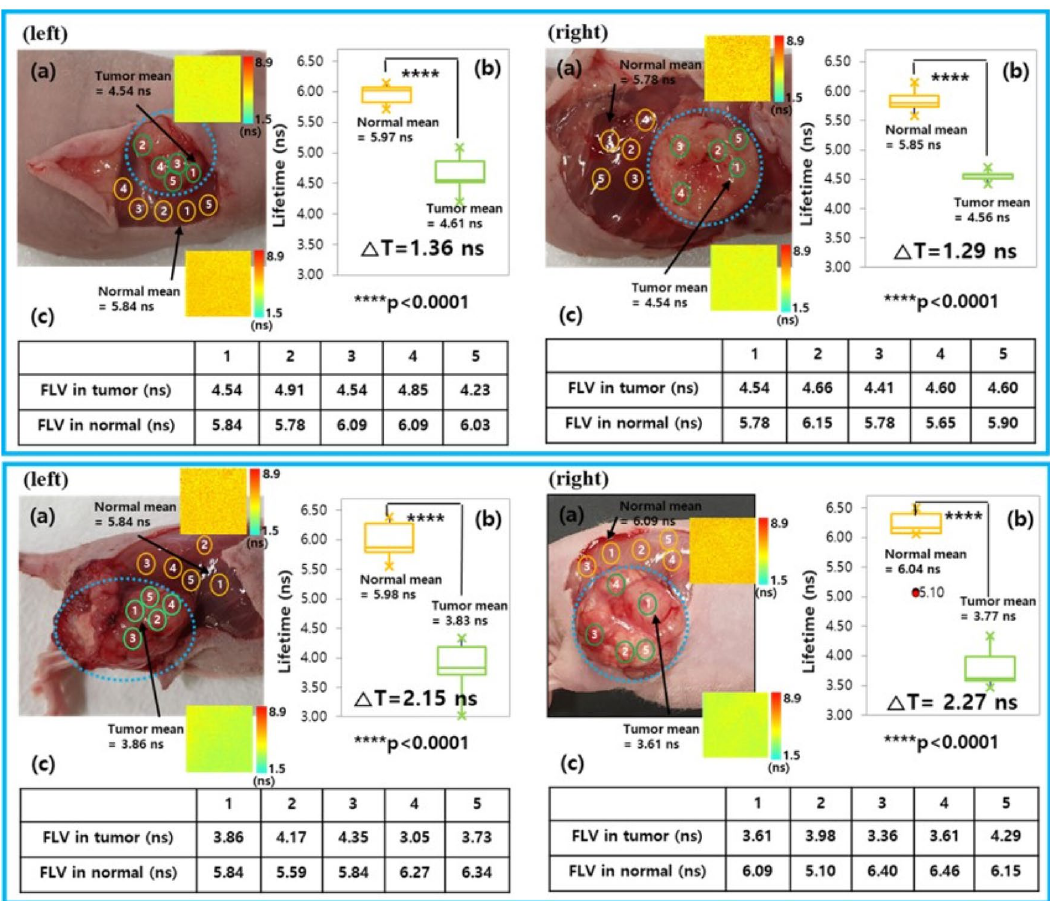
Figure 4. ( a ) Camera images showing the boundary between the cancer tissue and normal area and the point at which the fluorescence lifetime was measured in mice. ( b ) Distribution of fluorescence lifetimes within the tumor and normal tissues. ( c ) Fluorescence lifetime value for each point. The left and right panels represent the fluorescence lifetimes of different tumor sizes; the top and bottom represent the fluorescence lifetimes for MDA-MB-361 breast cancer and A375 skin cancer samples, respectively. (The color bar represents the fluorescence lifetime in nanosecond) ( △ T means the difference in fluorescence lifetime between the normal mean and tumor mean) (**** P < 0.0001, normal tissues versus tumor